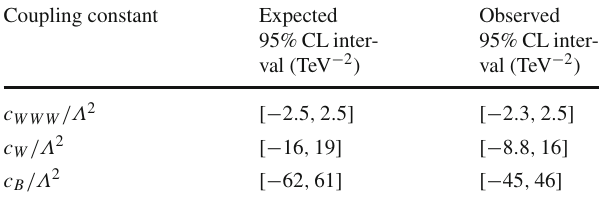
Table 4 One-dimensional limits on the ATGC effective Lagrangian (LEP parametrization) parameters at 95% CL Coupling constant Expected